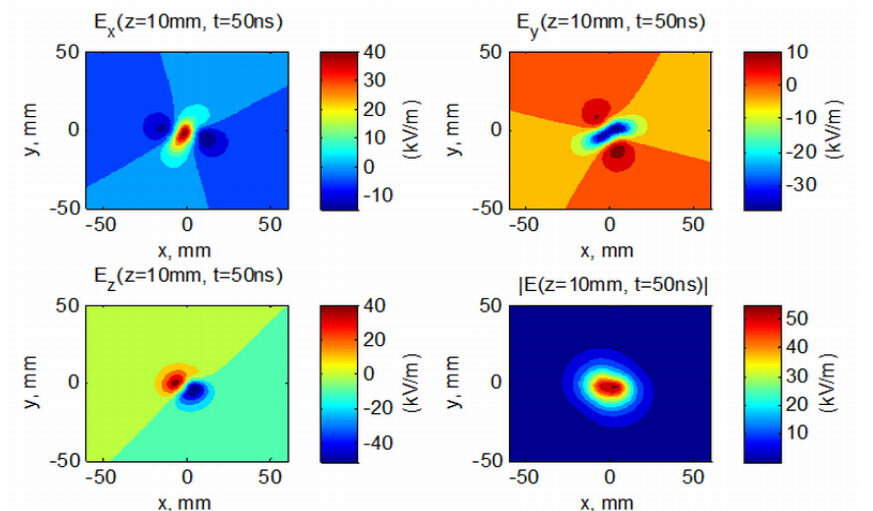
Figure 17: Calculated electric field components E x , E y and E z and the total magnitude | E | for the dipoles in Figure 14 at the horizontal plane at the height z = 10 mm at the instant time t = 50 ns.